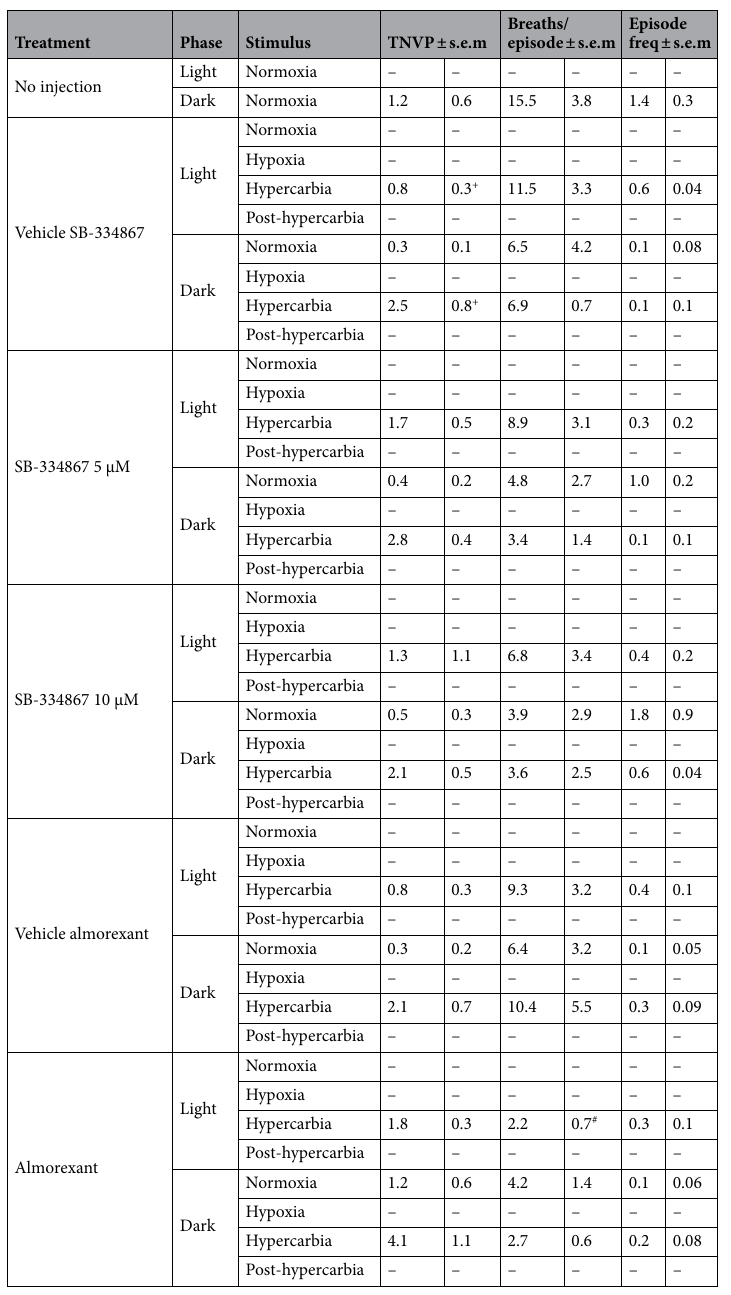
Table 1. Breathing pattern. Means ± s.e.m. of T NVP (min), number of breaths per episode and frequency of episodes (episodes min −1 ) of I. iguana microinjected with vehicle, SB-334687 or Almorexant exposed to room air, acute hypoxia or hypercarbia during light or dark phases. # Means different from the vehicle and + means different from